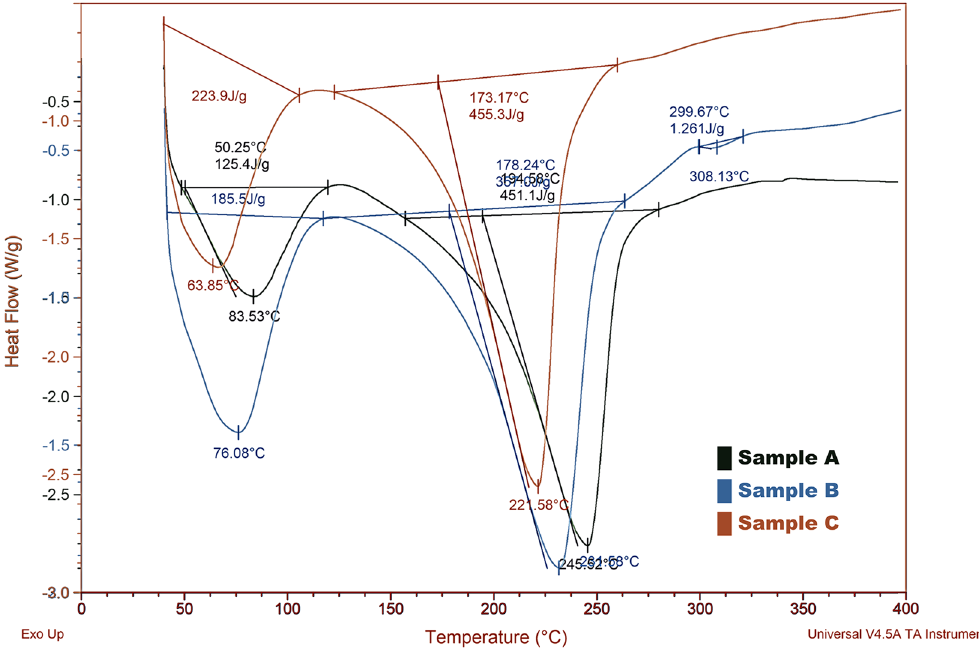
Figure 4. Differential Scanning Calorimetry (DSC) results of samples A, B and C.